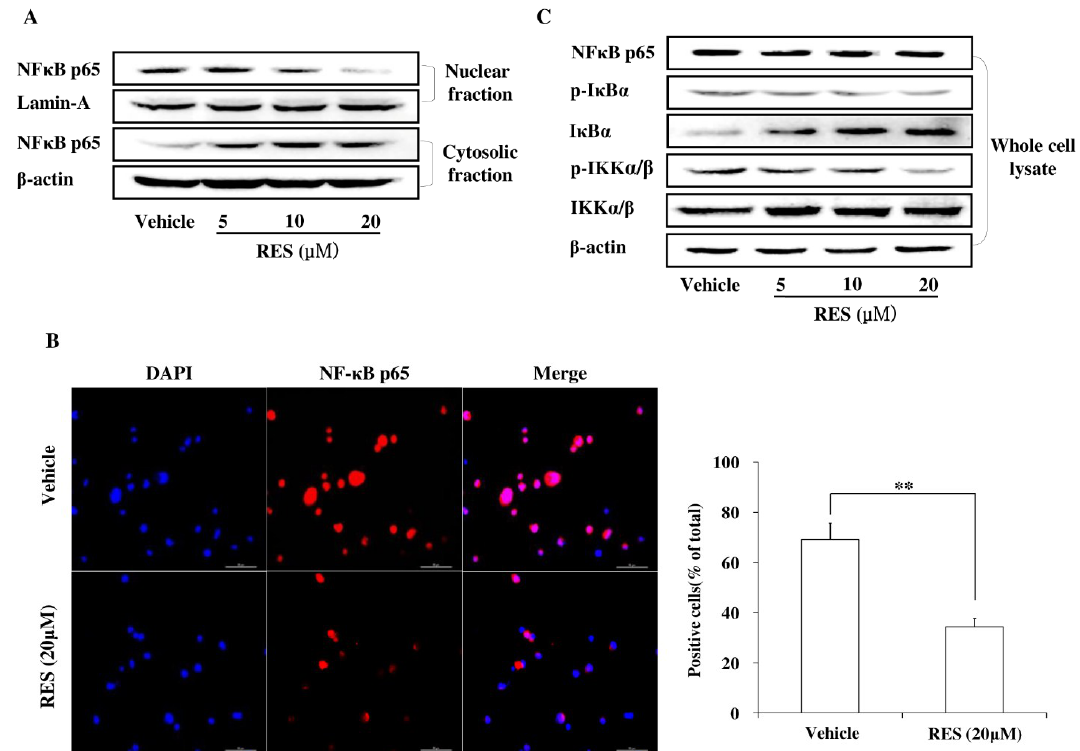
Figure 5. RES suppresses GIC invasion through the inhibition of the NF-κB pathway. ( A ) GICs (412) were treated with DMSO (vehicle) and 5 μM, 10 μM, and 20 μM RES for 48 h, respectively. Cytoplasmic and nuclear fractions of GICs were isolated, and the concentration of nuclear and cytoplasmic protein was measured by western blotting with an anti-NF- kB p65 antibody. Lamin A and β-actin were used as loading controls; ( B ) GICs (412) were treated with DMSO (vehicle) or 20 μM RES for 48 h and then immunostained with anti-NF-κB p65 and DAPI. Then, randomly chosen fields were photographed (400×) and the number of positive cells was calculated. Data are shown as the mean ± SD of three independent experiments by Student’s t -test. * p < 0.05, ** p < 0.01, vs. Vehicle; ( C ) GICs (412) were treated with DMSO (vehicle) and 5 μM, 10 μM, and 20 μM RES for 48 h, and the expression of target proteins was detected by western blotting using anti-NF-κB P65, anti-IκBα, anti-p-IκBα, anti-p-IKKα/β, anti-IKKα/β antibodies. β-actin was used as a loading control.